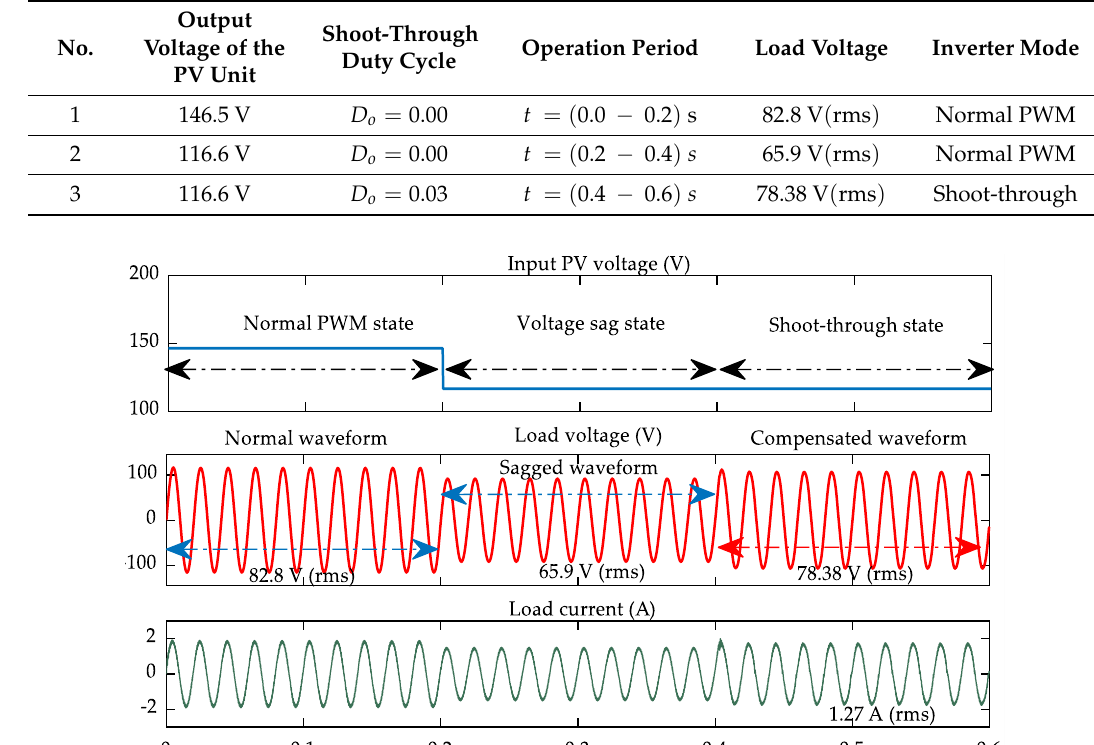
Table 3. Dynamic operation states.